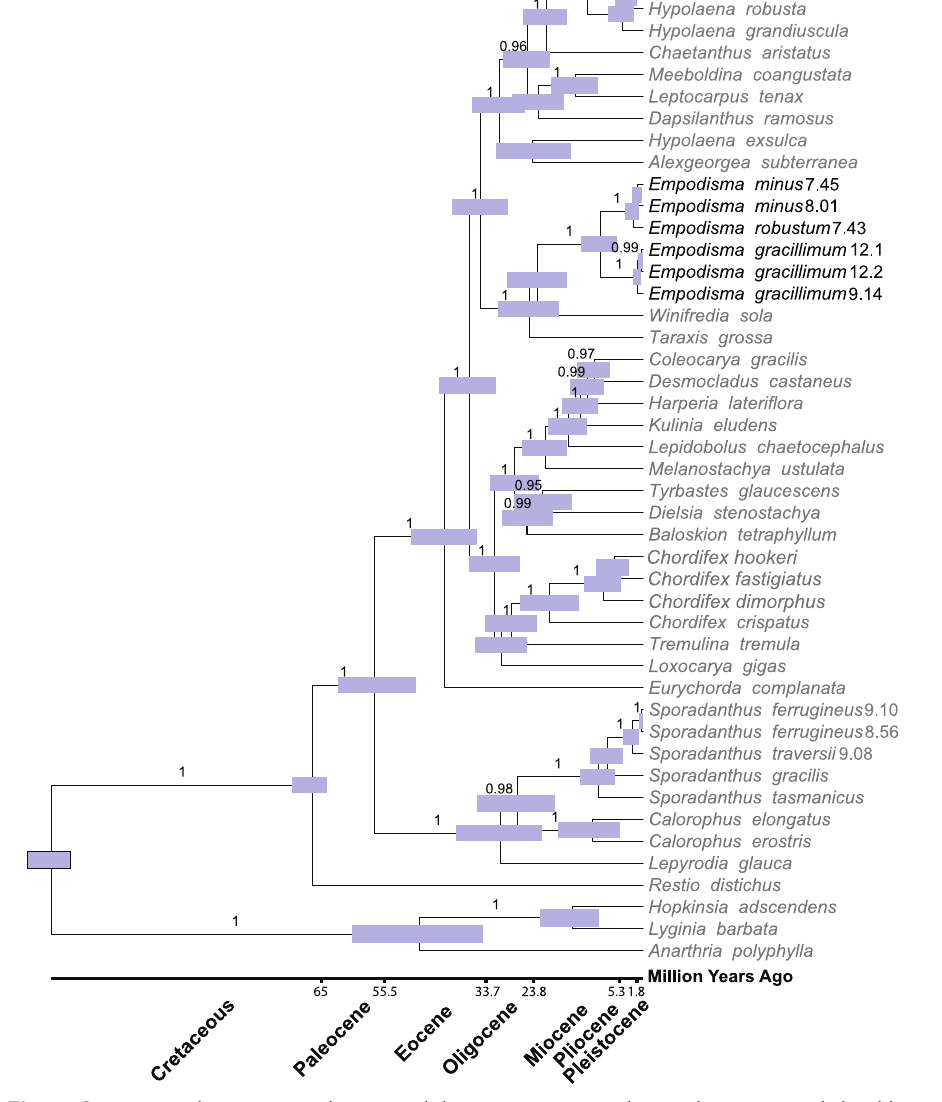
Figure 3. Bayesian chronogram with estimated divergence times. Node error bars are provided in blue showing the 95% highest probability density for the divergence estimates. Posterior probability support values > 97% are given above the branches. A geological time scale is shown at the base of the tree. ports only the diminutive accessions of E. minus from New Zealand (65% bootstrap), and one substitution supports the fourth split separating the large lowland form of Empodisma (e.g. E. robustum 7.43 highlighted in bold (68%